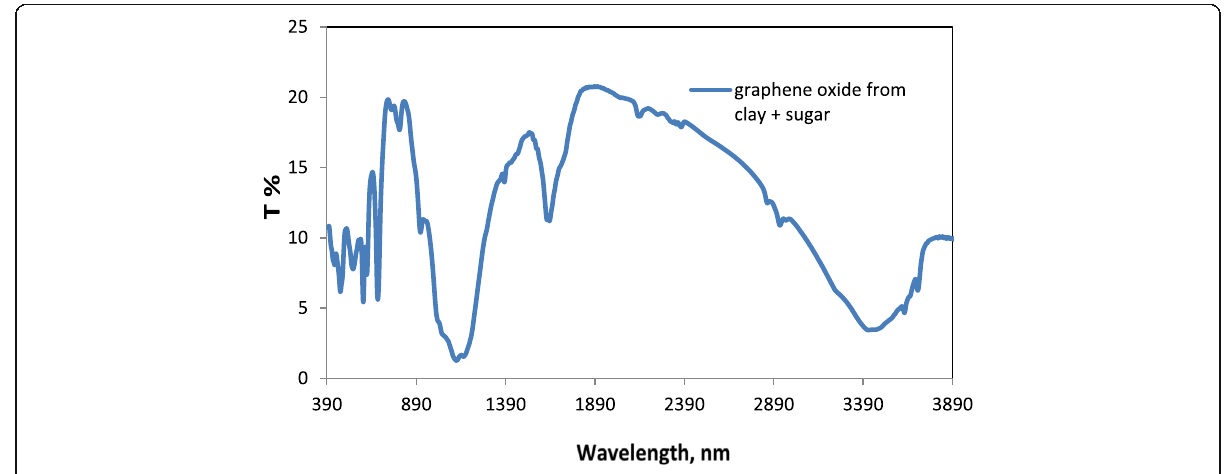
Fig. 12 FTIR analysis for synthesized nano graphene